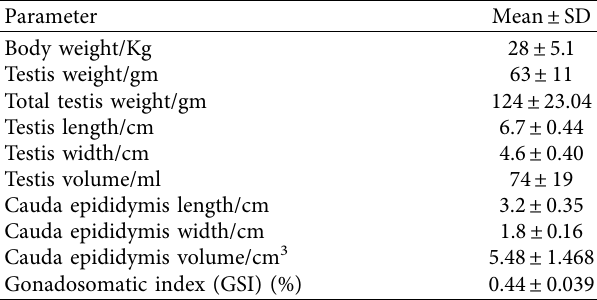
Table 1: Gross testicular morphometric parameters in Ghanaian WAD rams ( n �